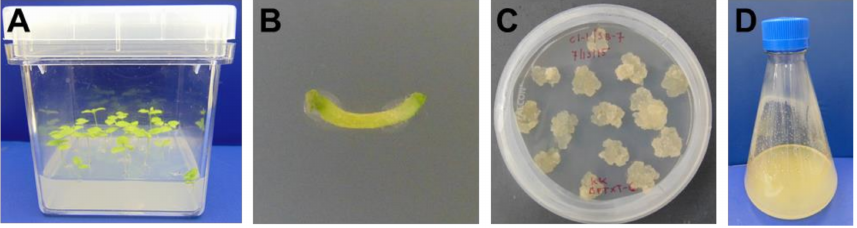
Figure 1. Callus generation. ( A ) Aseptically grown ∆ XTFT N. benthamiana plants; ( B ) Explant from ∆ XTFT N. benthamiana plant on semi-solid media; ( C ) ∆ XTFT N. benthamiana callus formed from dedifferentiation of explants and grown on semi-solid media; ( D ) ∆ XTFT N. benthamiana cells in suspension culture.